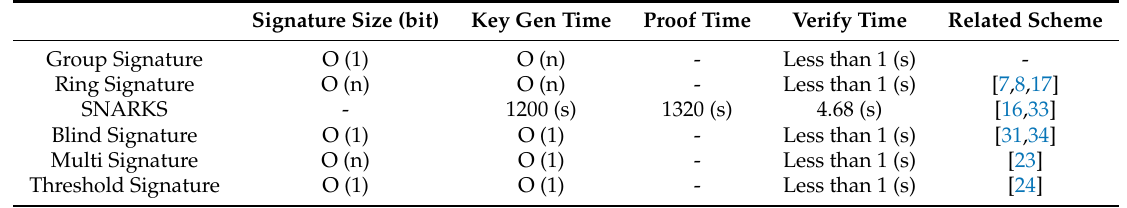
Table 4. A comparison of the efficiencies of anonymous digital